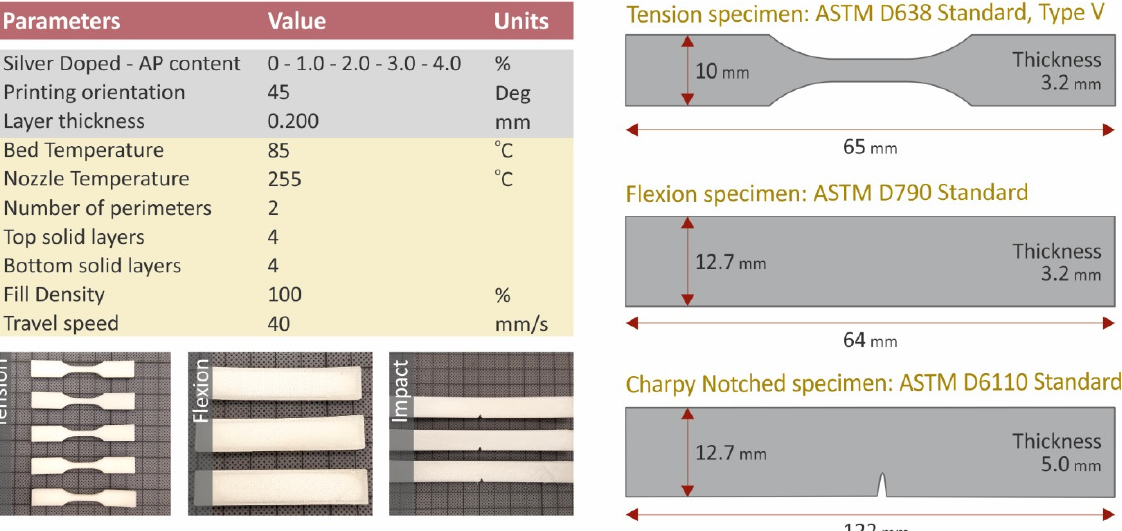
Figure 2. Fundamental 3D printing settings and specimen